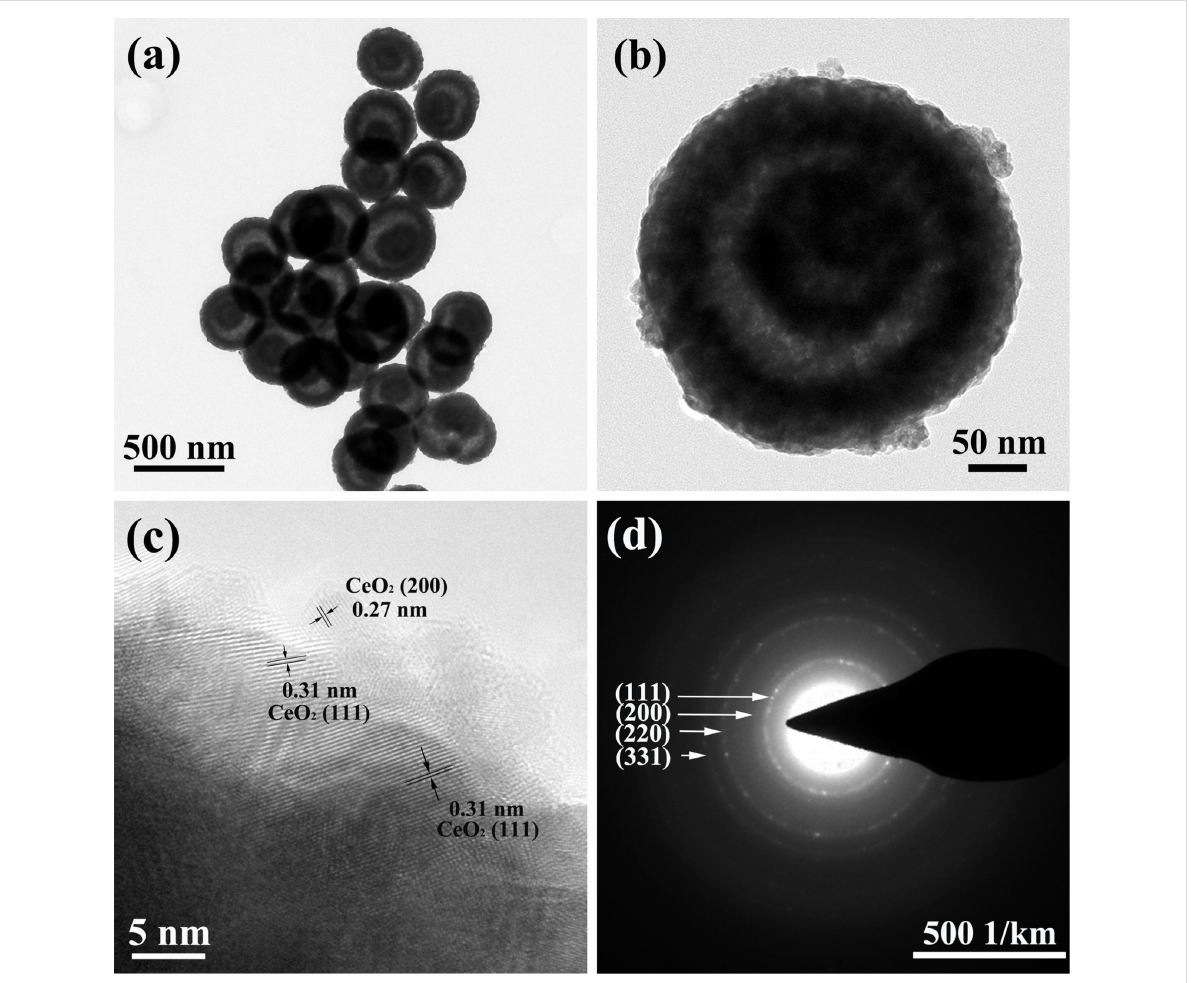
Figure 3: Low-magnification TEM images (a, b), high-magnification TEM image (c) and the SAED pattern (d) of the CeO 2 − CuO x composite yolk-shell